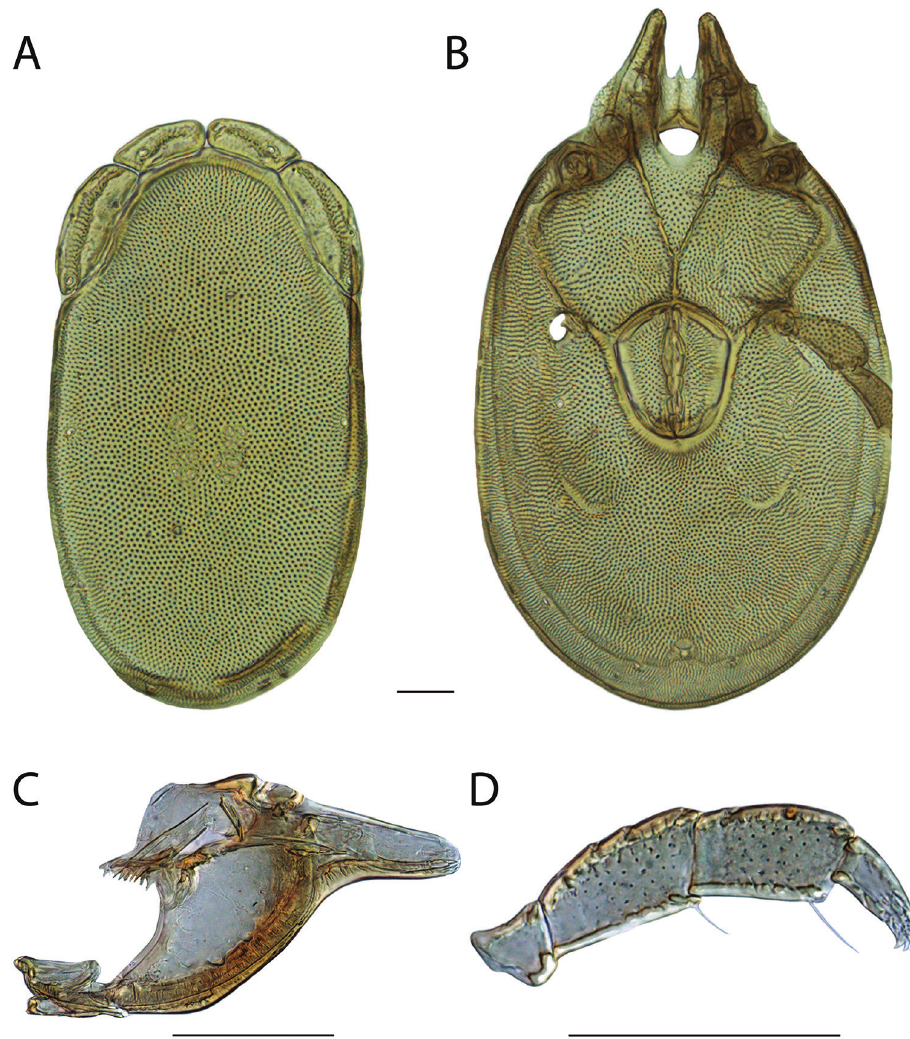
Figure 30. Torrenticola boettgeri female: A dorsal plates B venter (legs removed) C subcapitulum D pe- dipalp (setae not accurately depicted). Scale = 100